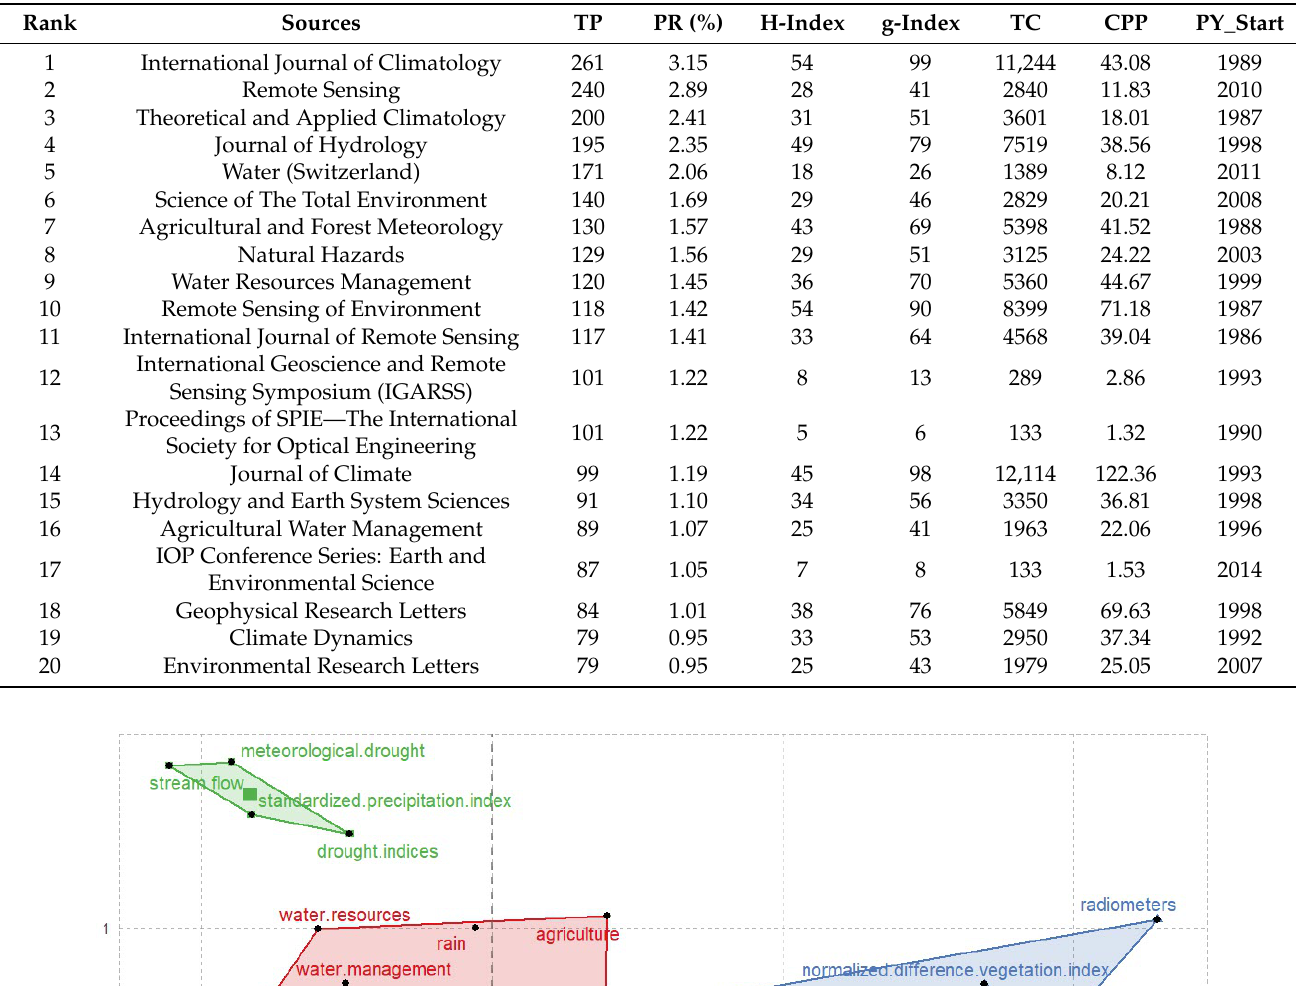
Table 2. Most productive sources for DIs. (TP is the number of total publications; PR (%) is the percentage of the number of one journal’s publications to the total number of publications; TC is total citation; CPP is the citations per publication, PY_start is the year of the first issue.).